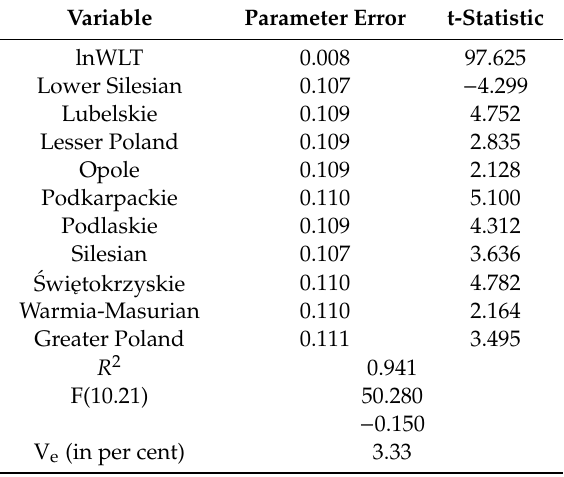
Table 1. Standard deviations of the estimations of structural parameters, values of t-statistic in the imperative